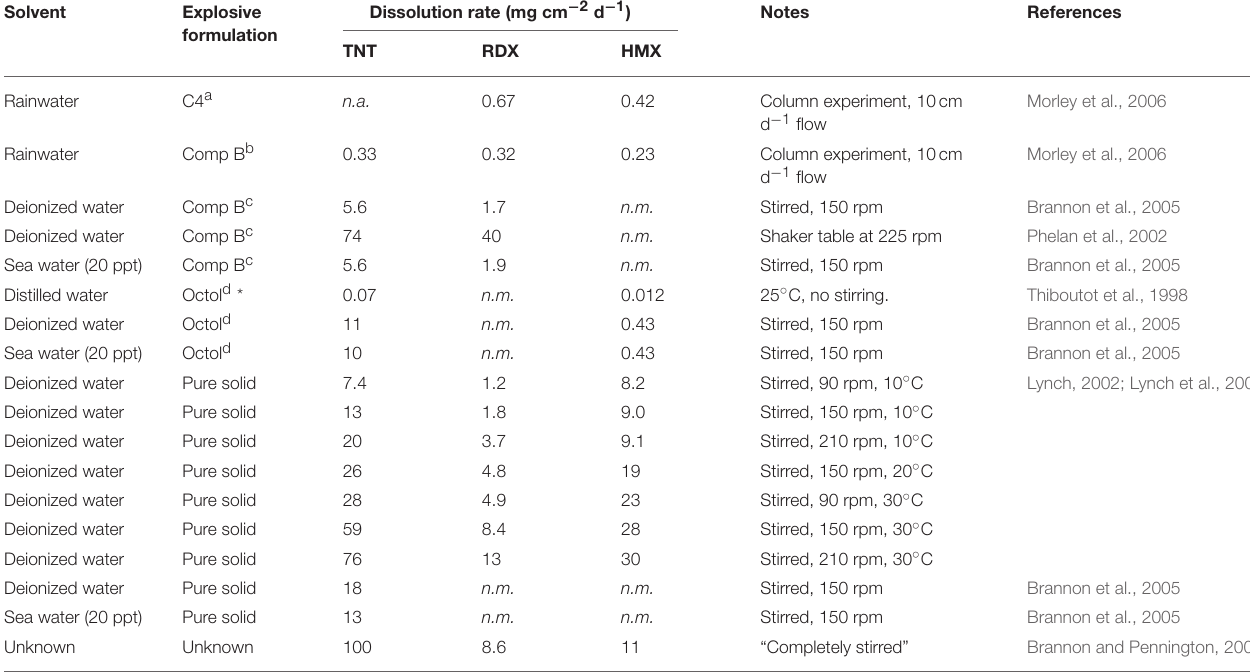
TABLE 3 | Dissolution rates of TNT, RDX, and HMX from pure and composite explosives.